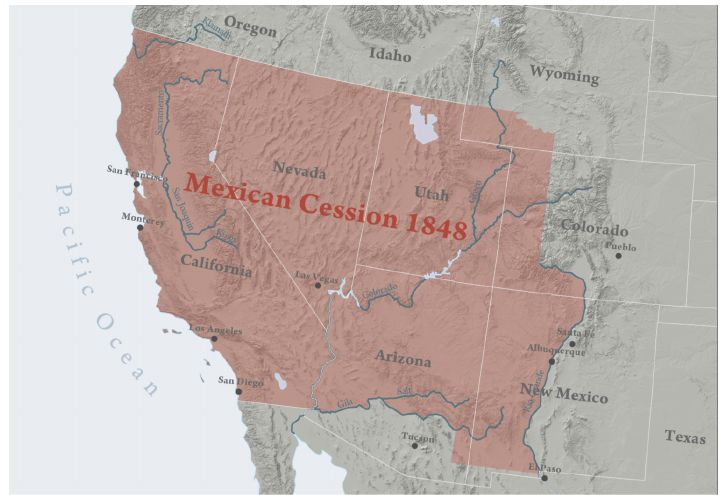
Figure A3. Mexican Cessions